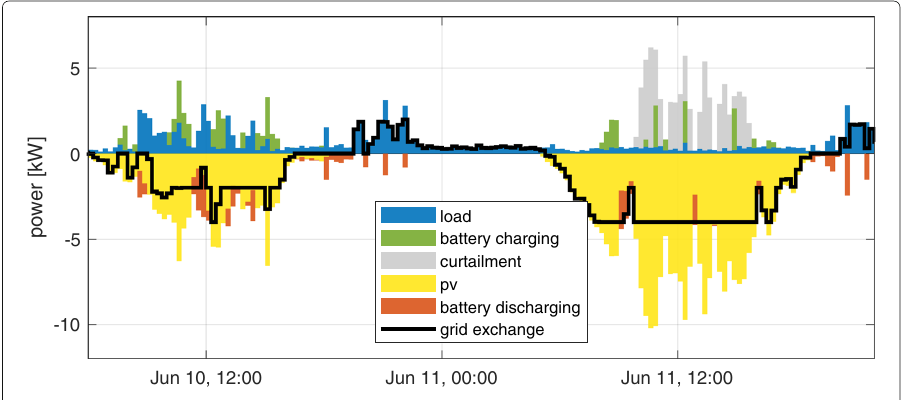
Fig. 5 Operation with the block rate